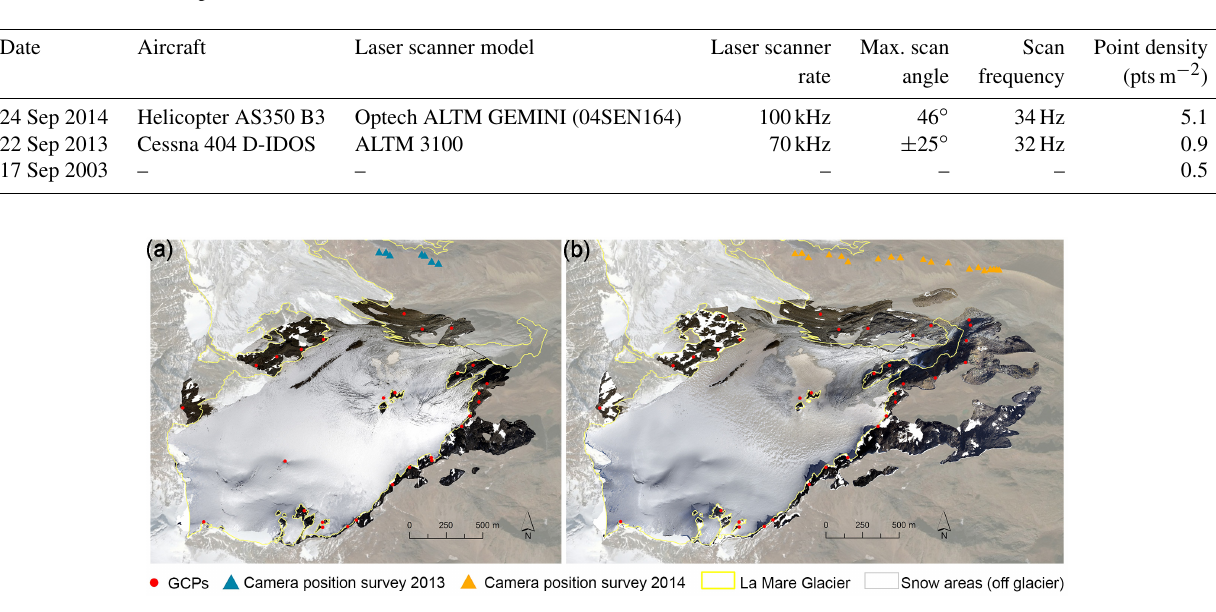
Table 1. Date and main parameters of available lidar data. The dash indicates that no information is available.